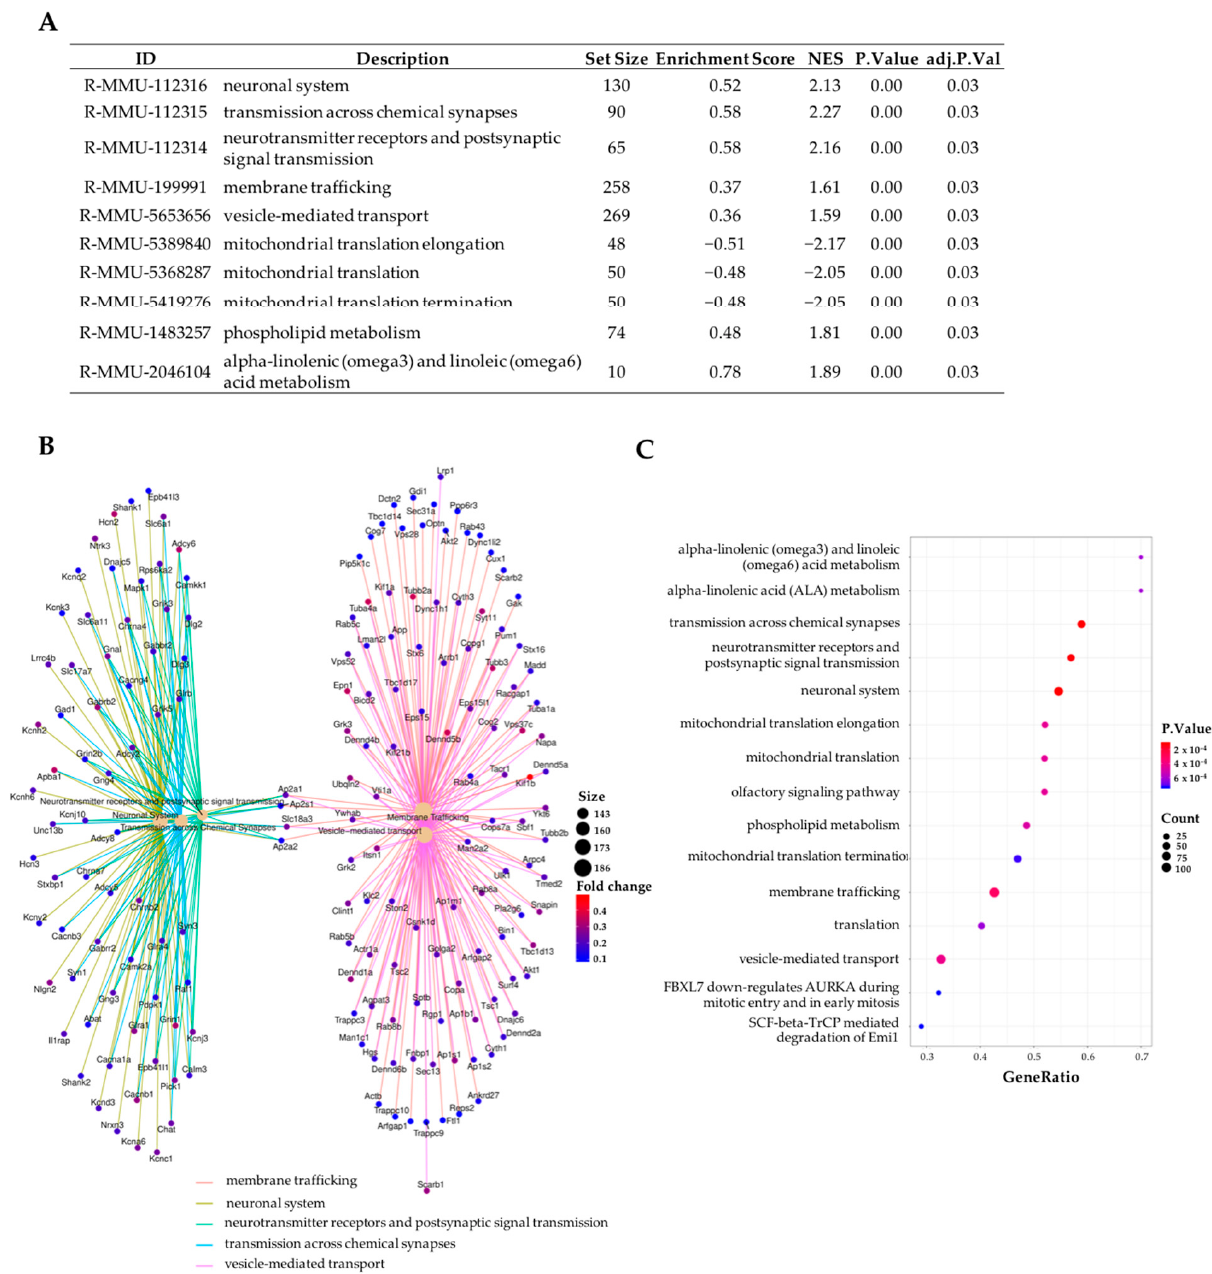
Figure 4. Enrichment analysis of the transcriptome comparison between vehicle-treated db/db mice and db/db mice treated with sitagliptin using the Reactome Pathway Database. ( A ) Table of the top 10 enriched pathways (Reactome Pathway Database) for the comparative study “db/db sitagliptin vs. db/db vehicle”. ( B ) Network plot of the top five enriched pathways for the comparison between db/db sitagliptin and db/db vehicle conditions (Reactome Pathway Database). ( C ) Dot plot of the top 15 enriched pathways (Reactome Pathway Database). The results shown correspond to the top enriched terms with an adjusted p -value < 0.05.